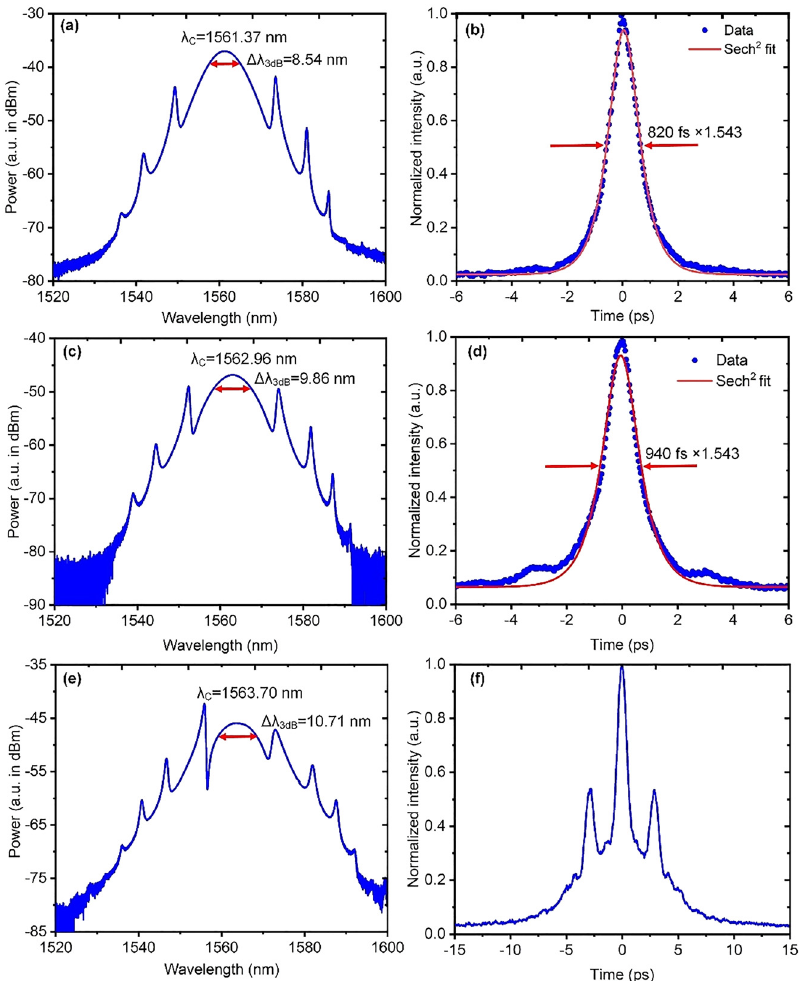
Figure5: SpectraandACtraceswhentheEDF laser was mode-locked by using three different lengths of BPQDs-coated TFs: (a) and (b) ∼ 20 mm; (c) and (d) ∼ 25 mm; (e) and (f) ∼ 30